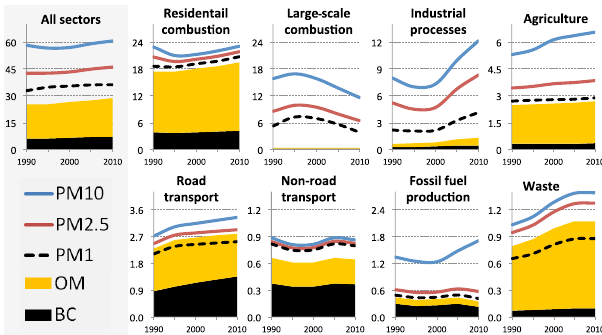
Figure 7. Global and sectoral emissions of PM species (Tg) in the period 1990–2010, ECLIPSE V5a